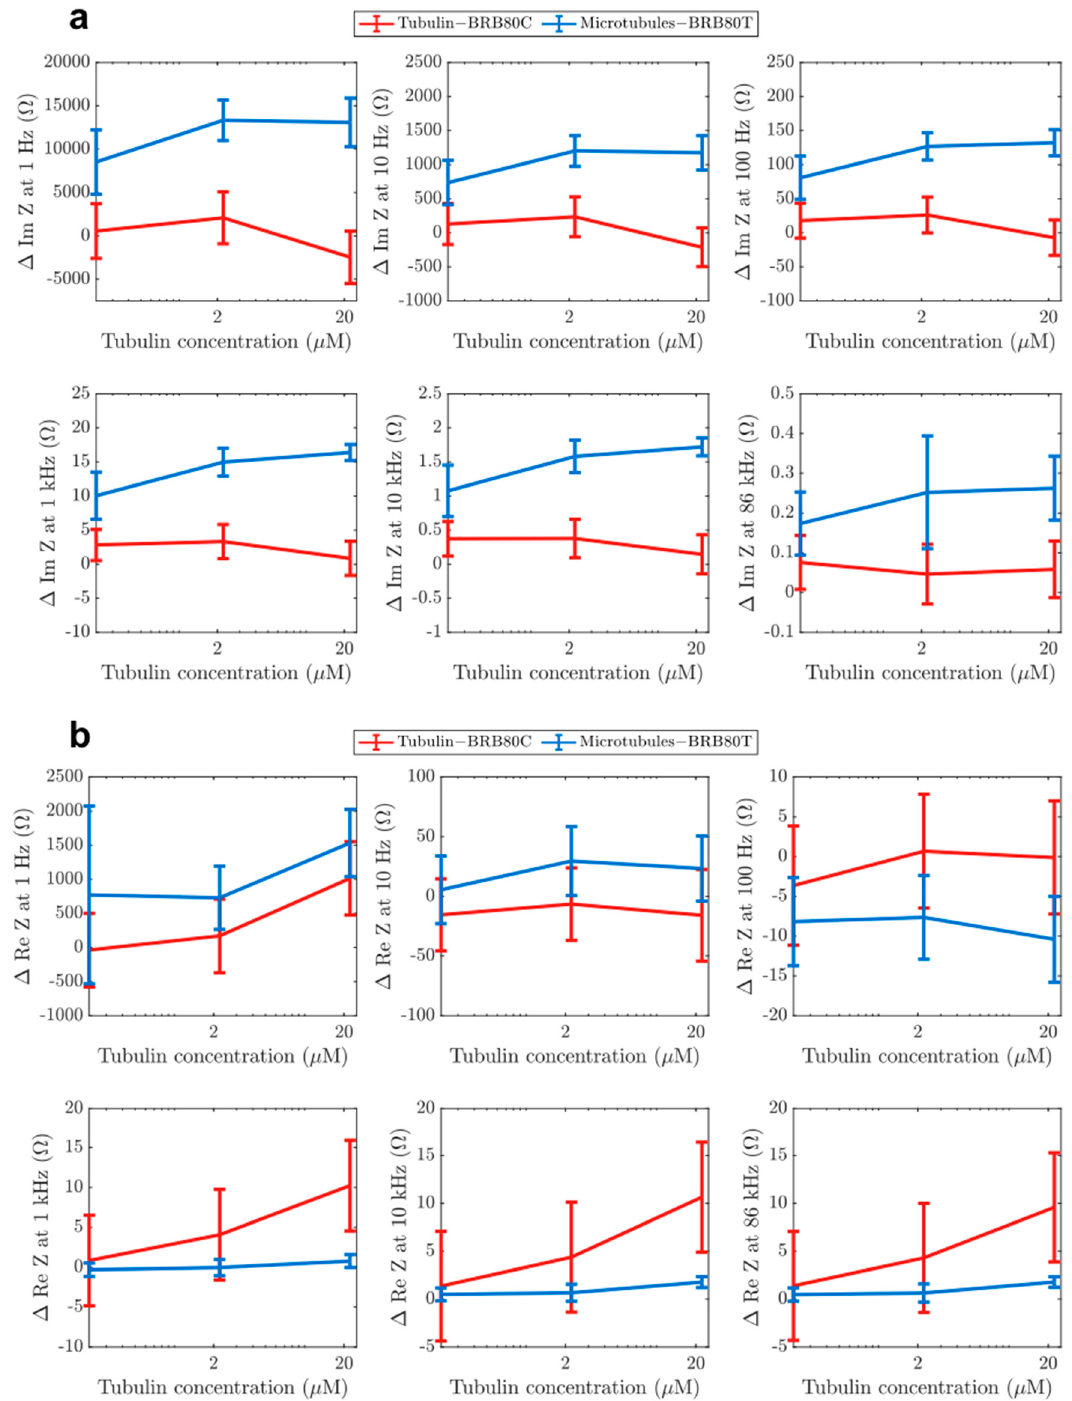
Figure 5. Graphs showing di ff erences in the ( a ) imaginary from Figure 3 and ( b ) real component of impedance from Figure 4 as a function of tubulin concentration at input AC frequencies of 1 Hz, 10 Hz, 100 Hz, 1 kHz, 10 kHz and 86 kHz. Graphs display average values. Error-bars represent standard